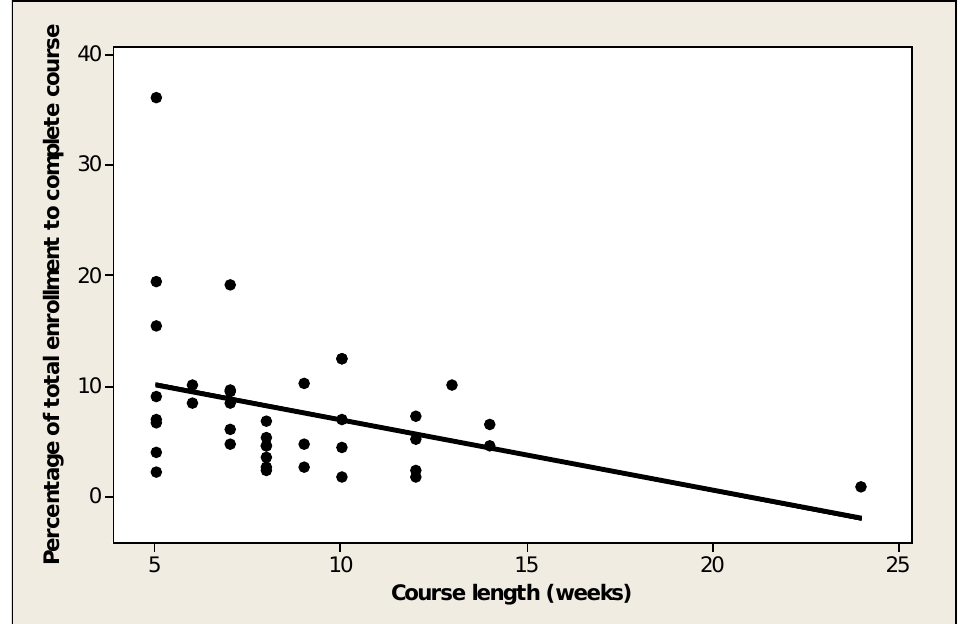
Figure 5 . Scatterplot of completion rate plotted against course length for the sampled courses ( n =